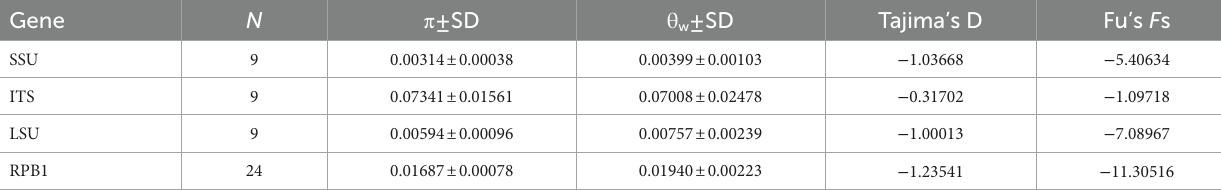
TABLE 6 Genetic diversity, Tajima’s D , and Fu’s F s in four gene regions of Pseudokabatana alburnus .